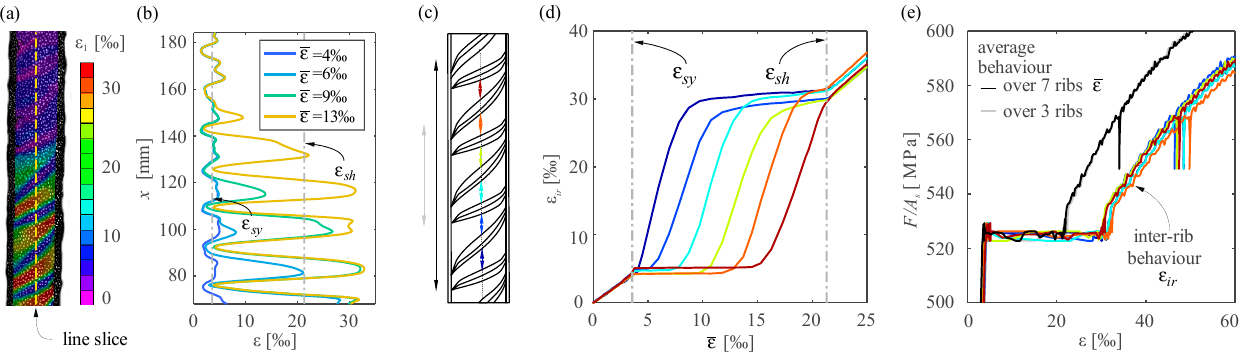
Figure 9. Progression of Lüders bands captured by DIC shown on specimen qst02: ( a ) strain field during yielding ( ε = 13‰); ( b ) strain distribution along the line slice in ( a ) at selected strain levels; ( c ) location of virtual gauges; ( d ) comparison of inter rib strains to mean strains over seven ribs, and ( e ) measured stress–strain behaviour with virtual gauges of different length and location.